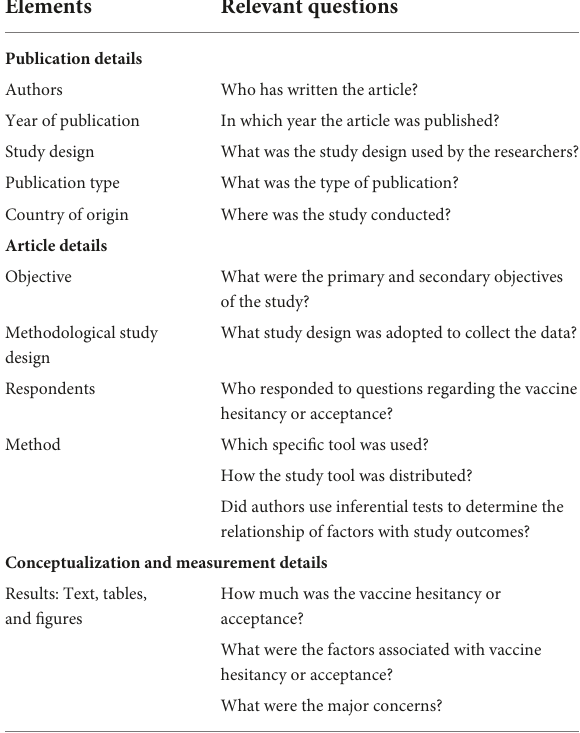
TABLE 2 Preliminary table of charting elements and relevant